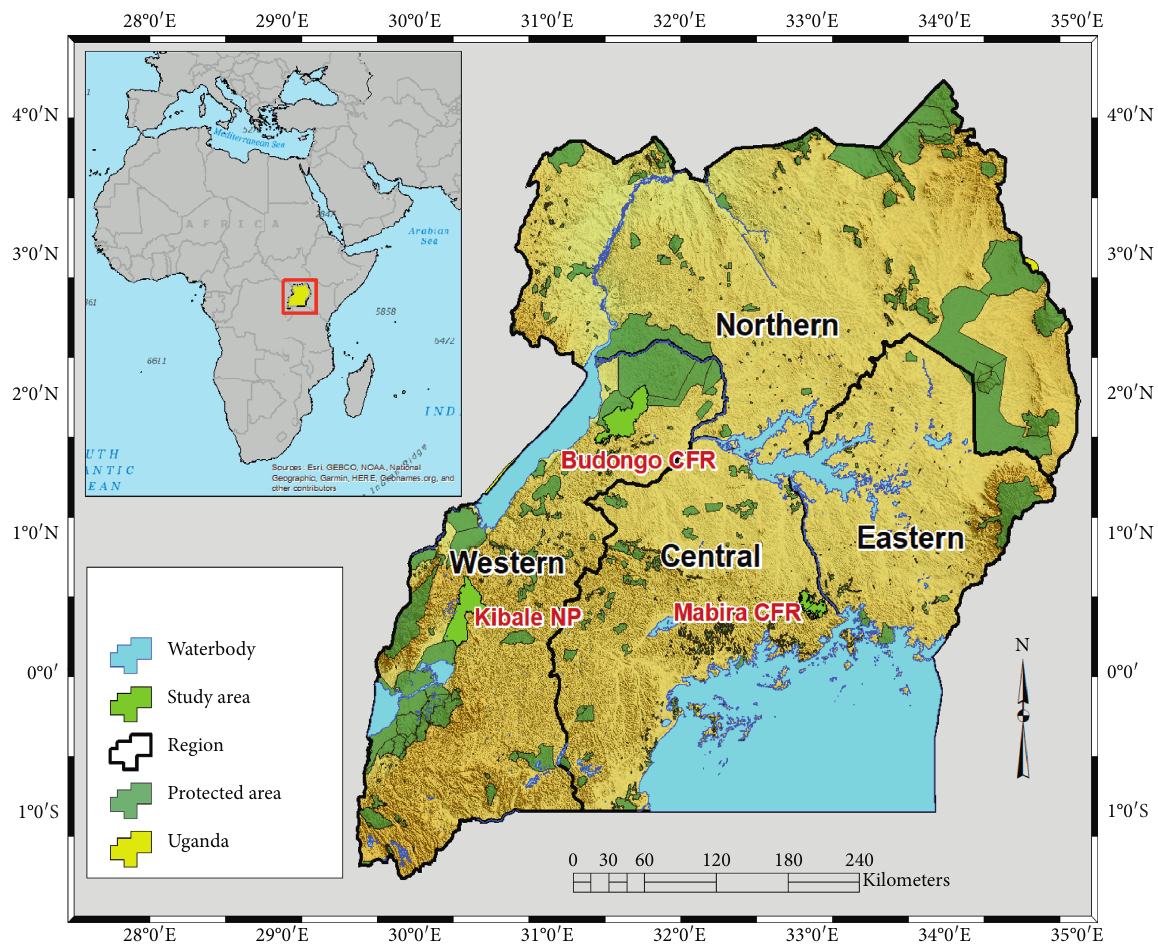
Figure 1: Location map of Budongo, Mabira, and Kibale Forest Reserves in